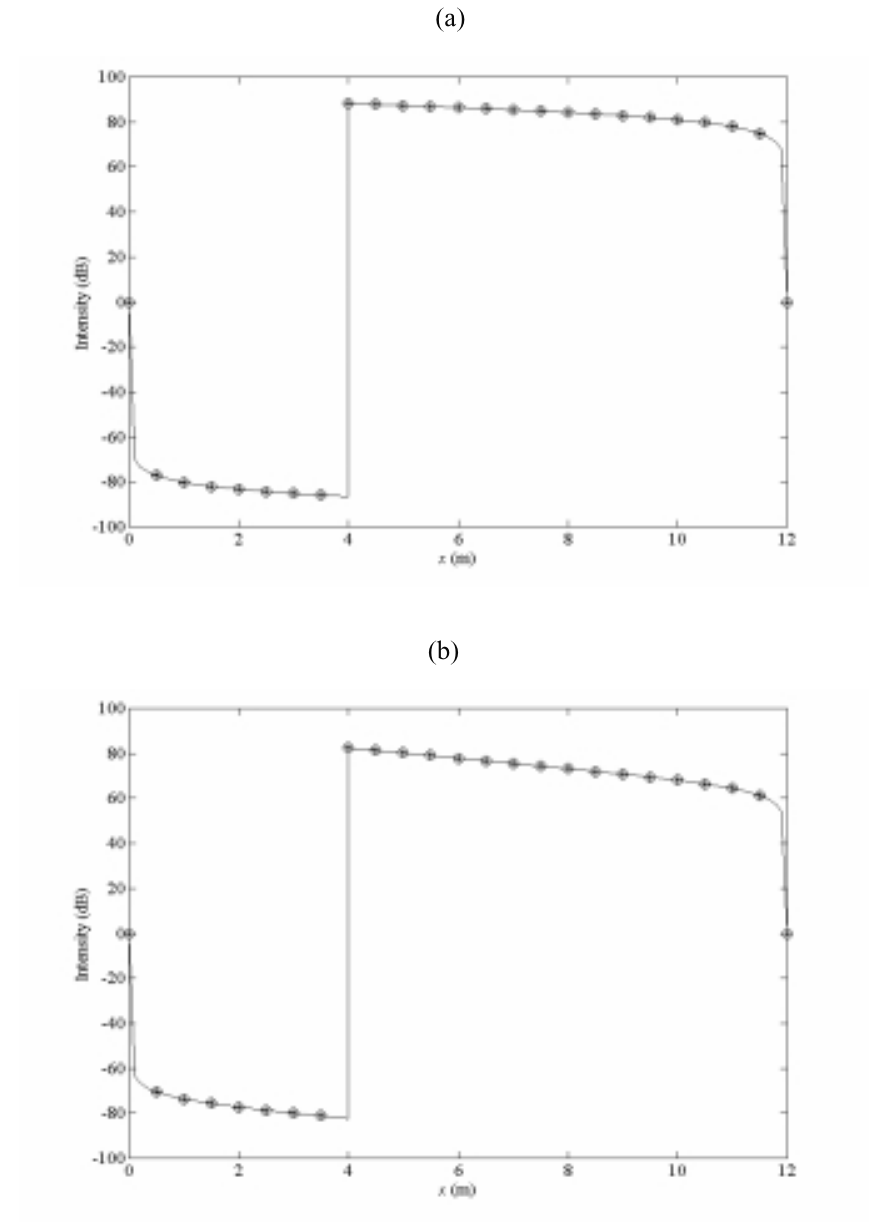
Fig. 3. Comparisons of intensity distributions in beam when η = 0 . 02 . The reference energy density is 1 × 10 − 12 J/m 2 ; (a) f = 1 kHz, (b) f = 10 kHz: —, EFA; , direct EFBEM; , indirect